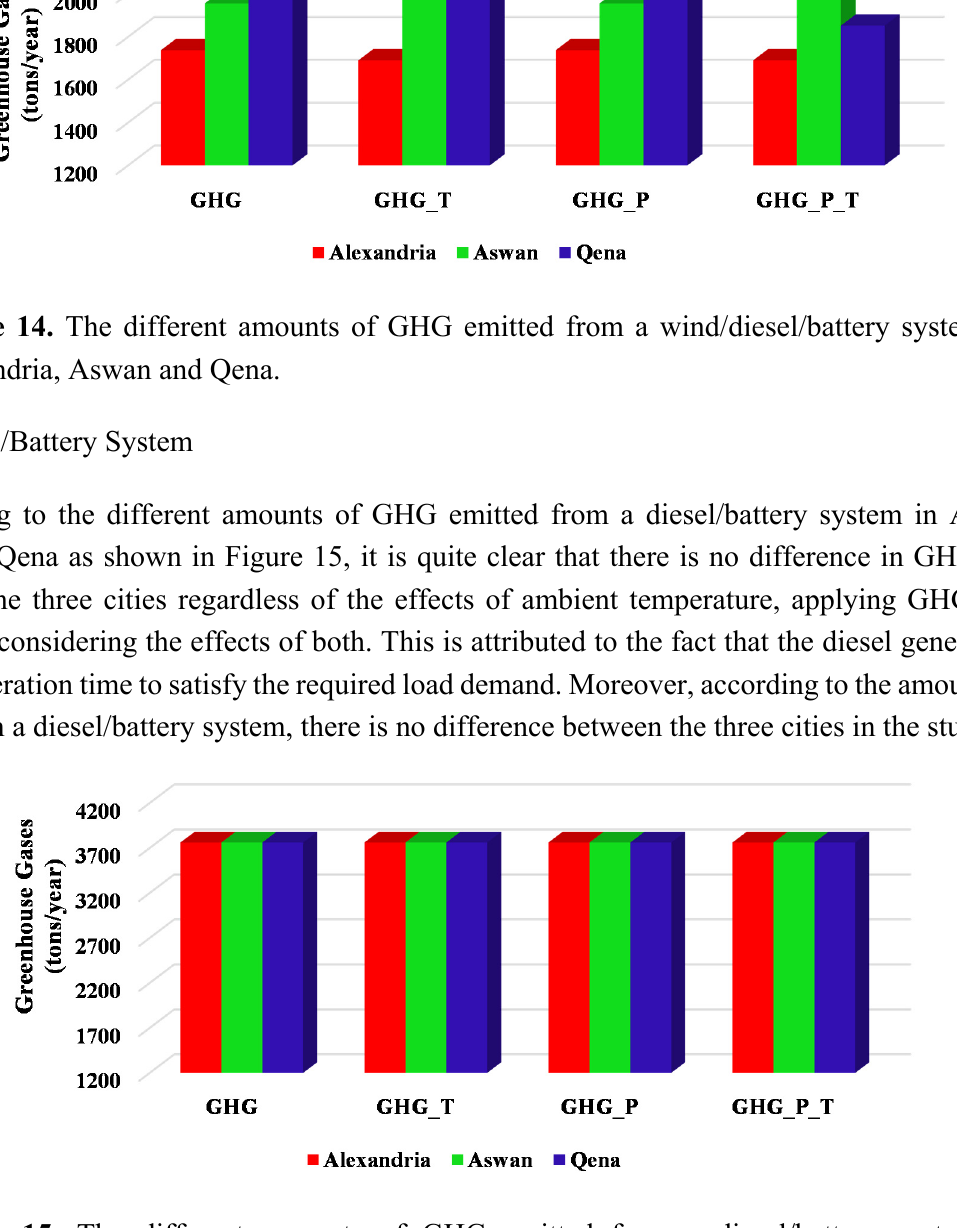
Figure 15. The different amounts of GHG emitted from a diesel/battery system in Alexandria, Aswan and